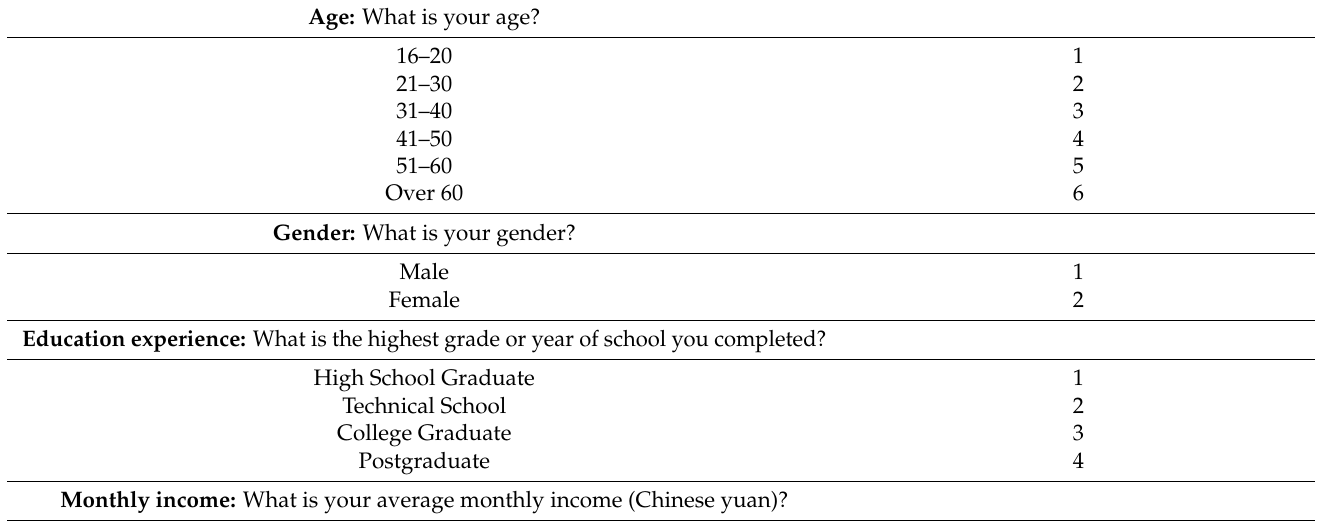
Table A2. Survey Variables Used in Regression Models.